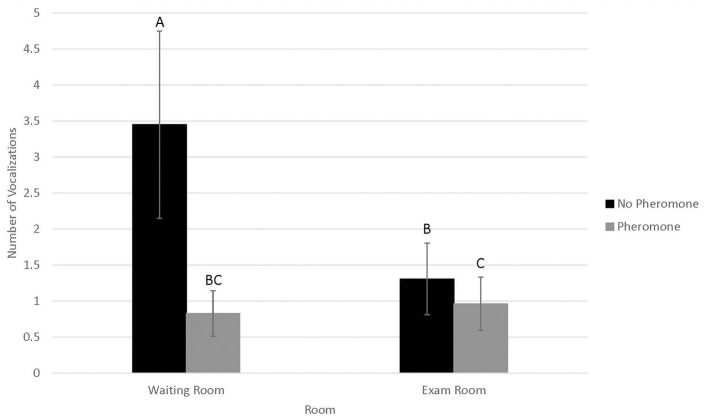
LSMean (±SE) number of feline vocalizations during a 10-min acclimation period in a veterinary clinical exam room. Over four visits, 39 cats1 were randomly assigned to one of four possible treatment combinations (WR+/FFP+, WR+/FFP–, WR–/FFP+, WR–/FFP–),2 which were experienced for 10-min prior to the acclimation period and blood pressure measurements. Columns letters denote statistical differences between visits (P < 0.05). 1All enrolled cats were mature, healthy, and either spayed or neutered. 2WR+: owners and their cats stayed in the waiting room lobby at veterinary clinic for 10 min prior to being taken into the exam room for blood pressure measurements; WR–: owners and their cats were immediately taken into the exam room where they waited for 10 min prior to blood pressure measurements; FFP+: a clean towel was sprayed with feline facial pheromone and placed in their carriers during the 10 min acclimation period; FFP–: no feline facial pheromone was provided.